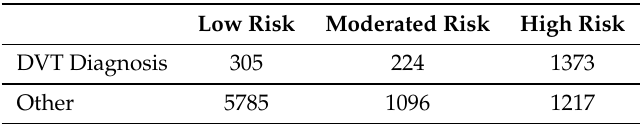
Table 2. Distribution of risk cases in a dataset of 10,000 synthetic